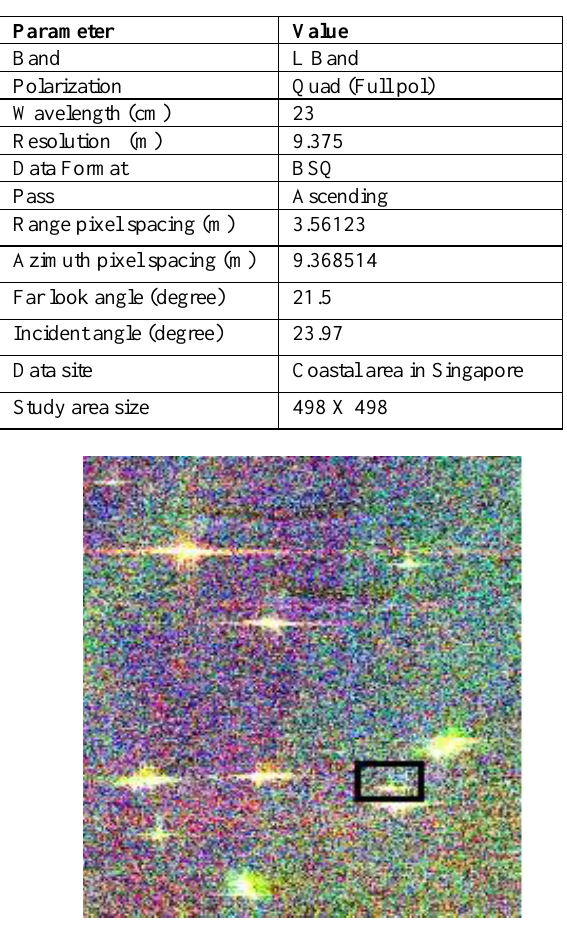
Table 2 ALOS-1 Vessels detection rate of Sub-image (A)